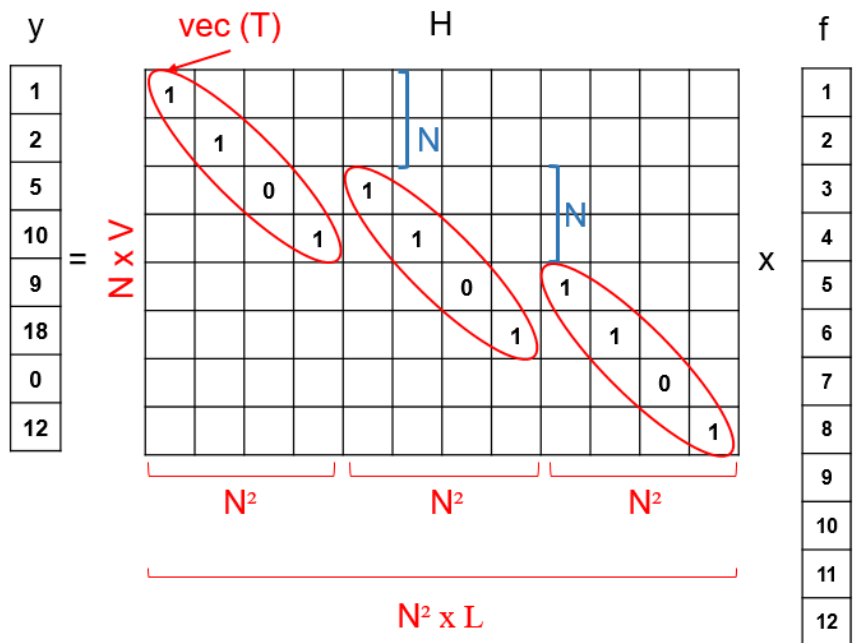
Figure 3. Equivalent CS formulation with the particular structure of the projection matrix H